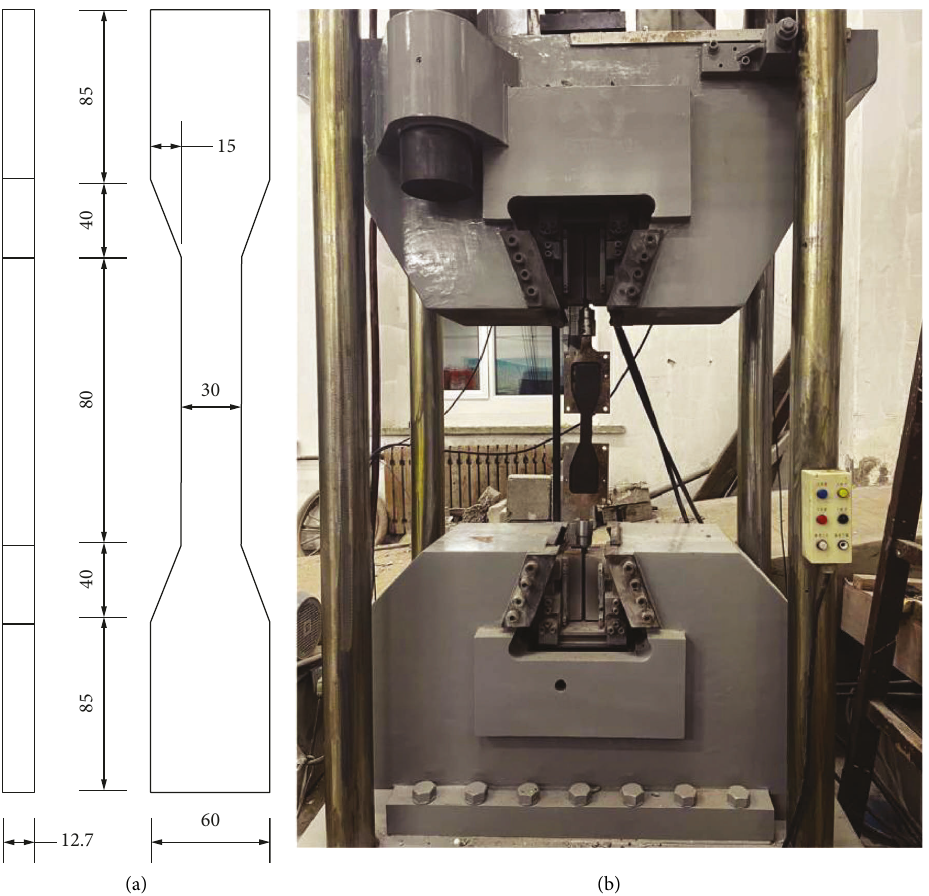
Figure 5: Tensile strength test. (a) Dumbbell type axial tension specimen dimensions, unit: mm. (b) Tensile test loading.